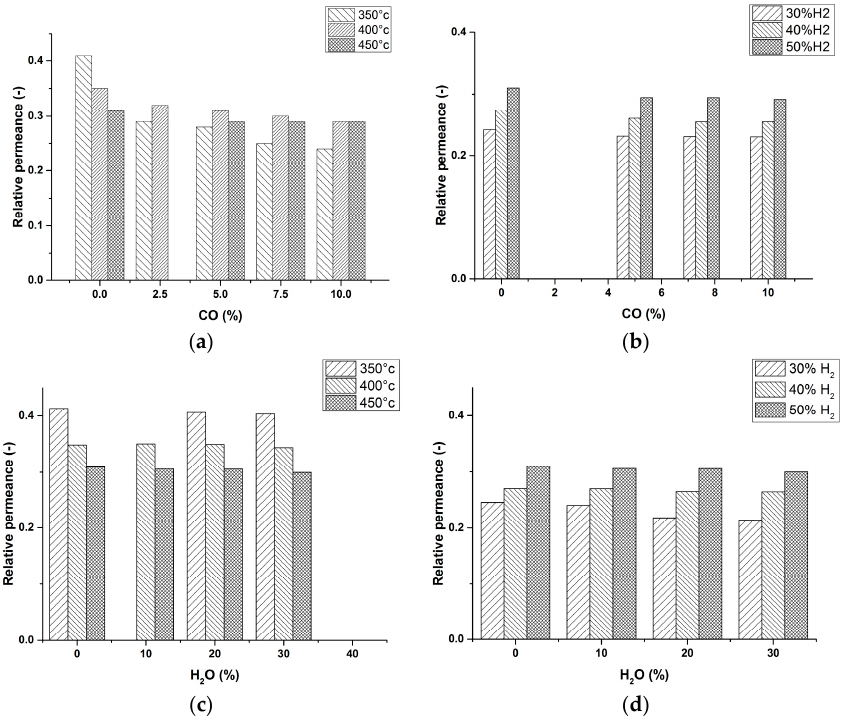
Figure 3. CO poisoning and H 2 O inhibitory effect on the performance of the membranes at different temperatures with H 2 /CO/N 2 and H 2 /H 2 O/N 2 feed gas compositions. ( a ) CO poisoning effect at different temperatures and constant H 2 concentration in feed (50%), N 2 (balance); ( b ) CO poisoning at different H 2 concentration in the feed at 450 °C; ( c ) H 2 O inhibitory effect at different temperatures and constant H 2 in the feed (50%), N 2 (balance); ( d ) H 2 O inhibitory effect at different H 2 concentration in the feed at 450 °C. Relative permeance is the performance of the membrane module at the specified condition normalized with the case when only pure H 2 was used with exactly the same partial pressure difference.